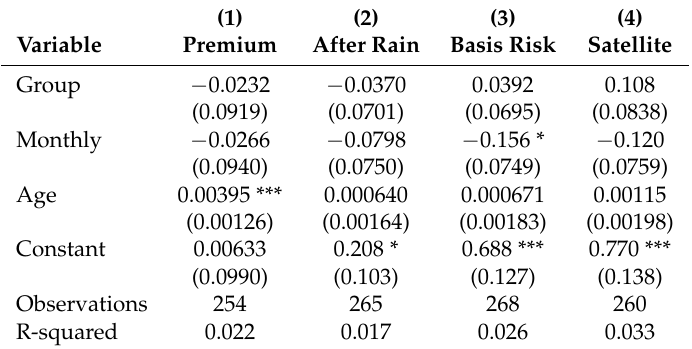
Table 10. Effect of Offering Group Insurance on Exit Survey Comprehension